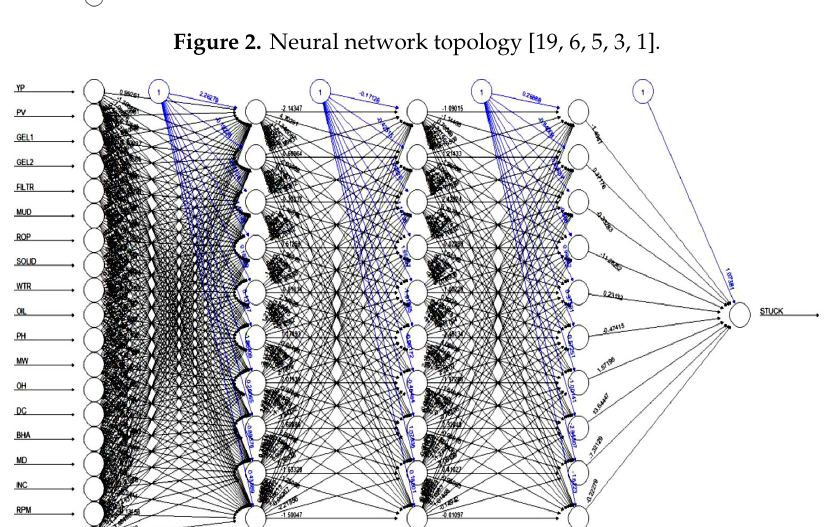
Figure 3. Neural network topology [19, 10, 10, 10, 1].